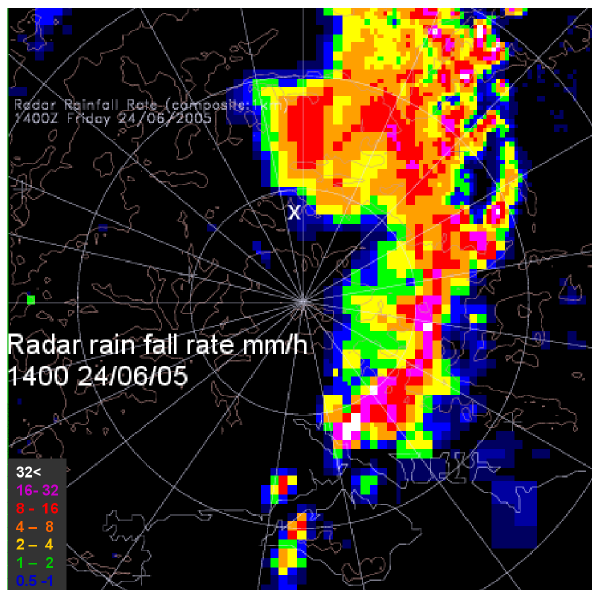
Fig. 5b. Composite weather radar rainfall for the 24 June 2005 at 10:00UTC. The white cross indicate Linkenholt site. The rain rate/h is indicated by the colour scale on the bottom left. The bulls- eye is centred at the Chilbolton radar with the first and second cir- cles of radius 25 and 50km.